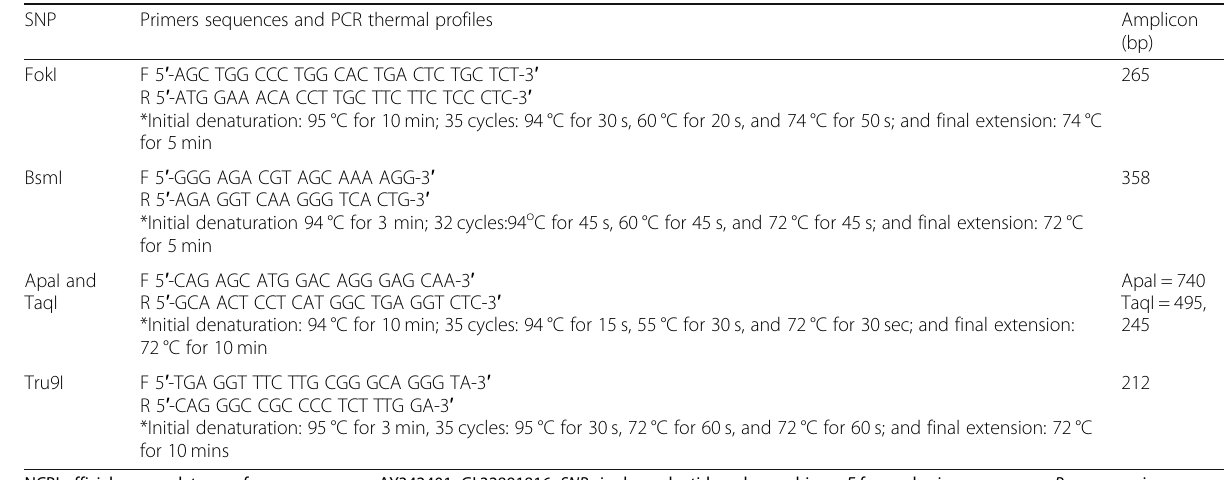
Table 1 Primers sequences and PCR thermal profile of VDR gene polymorphisms SNP Primers sequences and PCR thermal